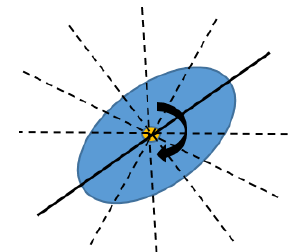
Figure 10 Schematic diagram to find the main direction of a spalling region.